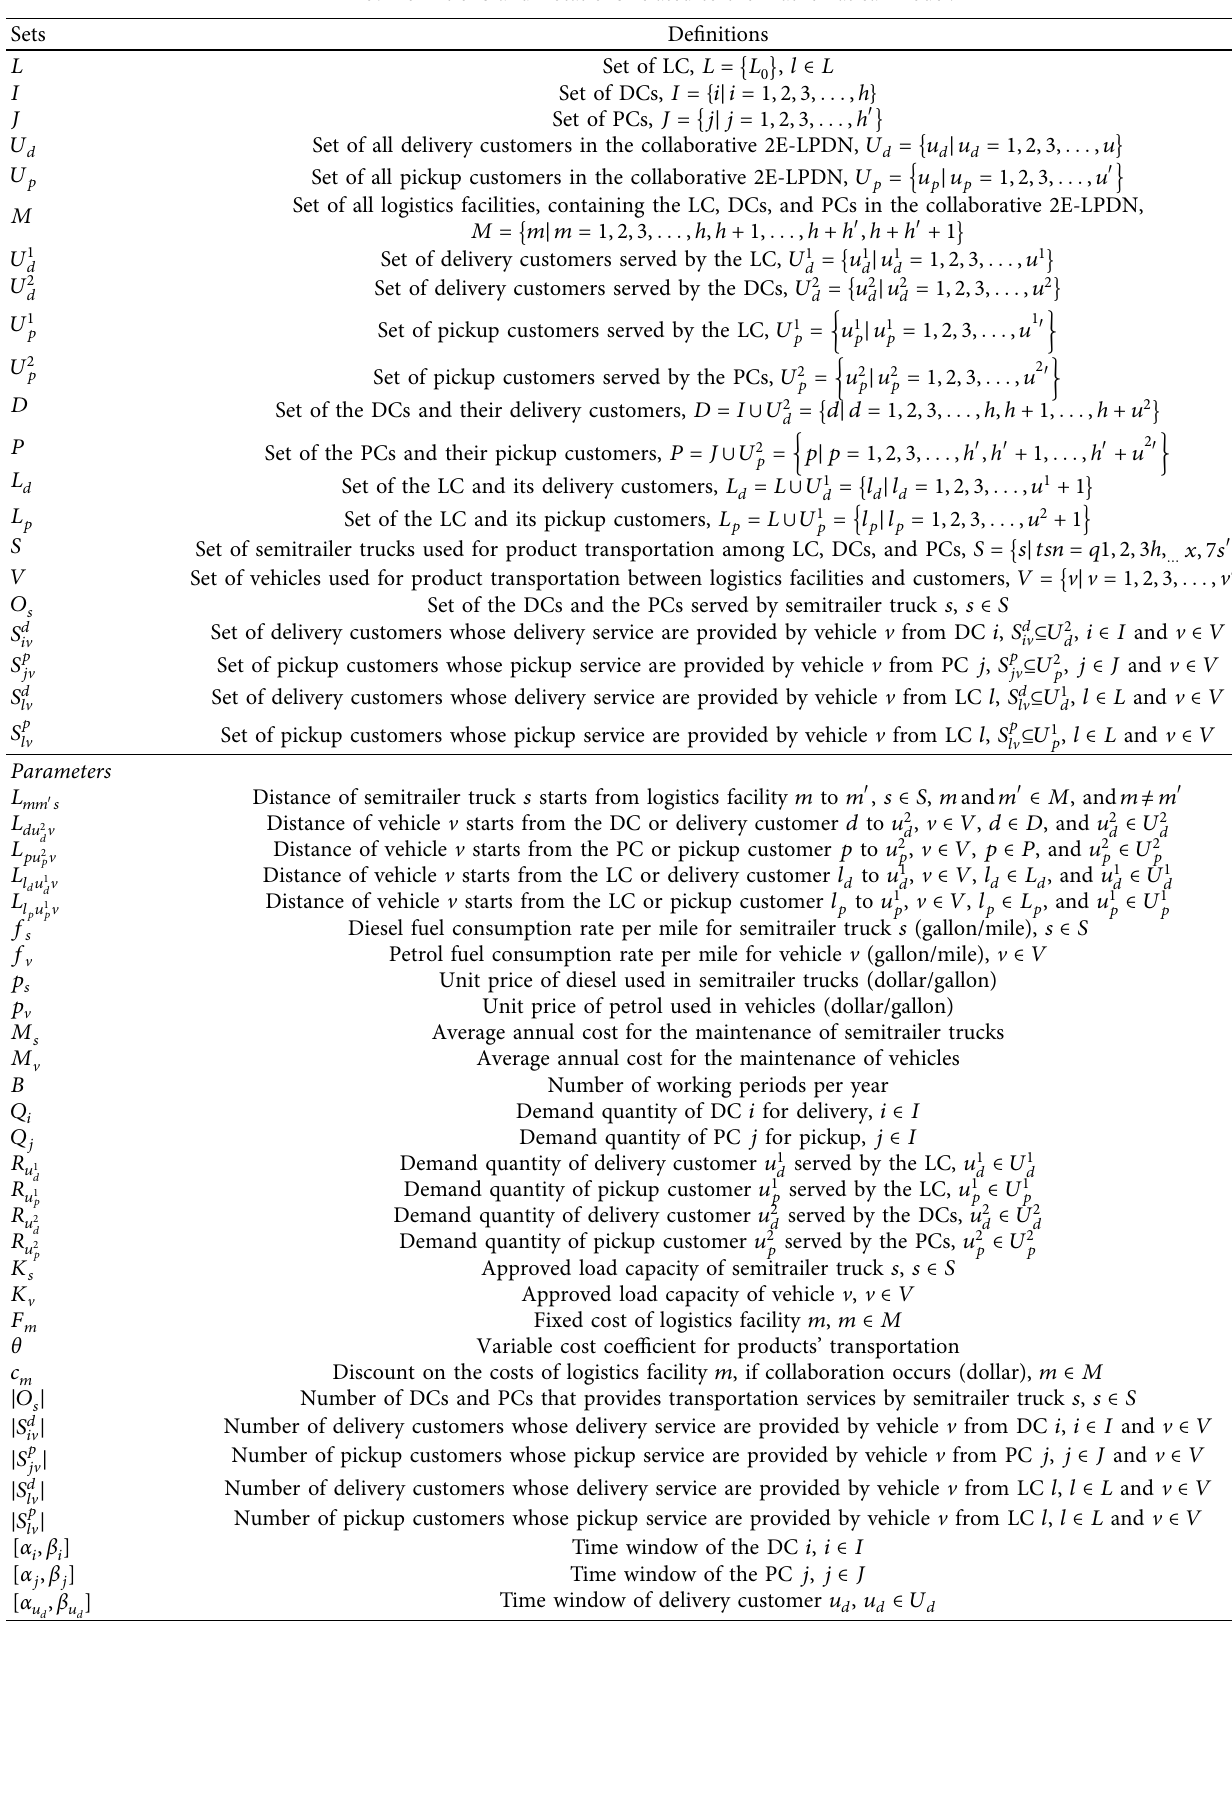
Table 3: Definitions and notations related to the mathematical